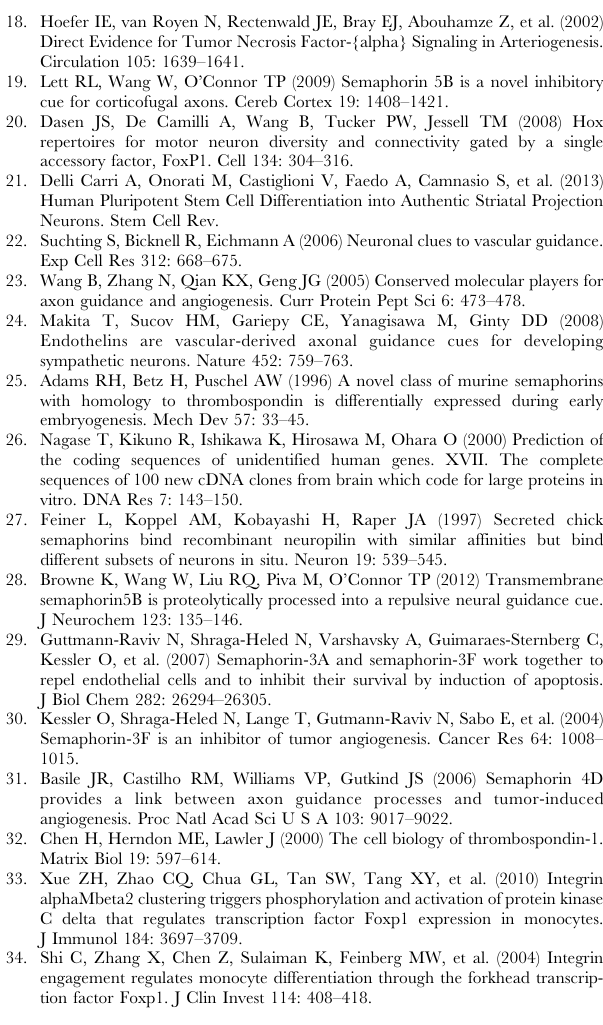
Figure S1 Knockdown of FoxP1 by two different siRNAs attenuates vascular smooth muscle cell